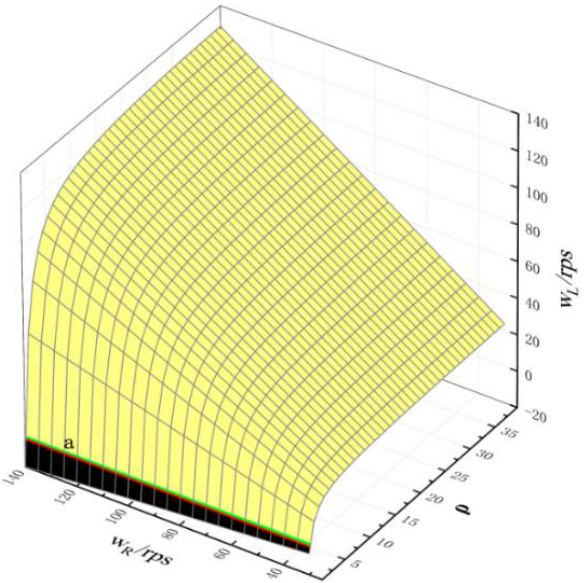
w w Figure 5. The corresponding relationship between w R , w L and ρ under cement pavement.  Figure 5. The corresponding relationship between R , L and under cement pavement. Curve a is the equivalent curve when b = 0, indicating that the implicated velocity of the left track of the robot is 0. Below curve a is a negative value, indicating that the track rotation direction is opposite to the prescribed direction. Above curve a is a positive value, indicating that the track rotation direction is the same as the prescribed direction. As shown in Figure 5, when the tracked robot is in steering motion, the magnitude and direction of the left speed track speed are also different to complete the curve motion with different relative steering radii when the right track speed is fixed. For example, when ρ is small, w L is negative, which is opposite to the rotation direction of w R . When ρ gradually increases, w L changes from negative to positive, which is the same as the rotation direction of w R